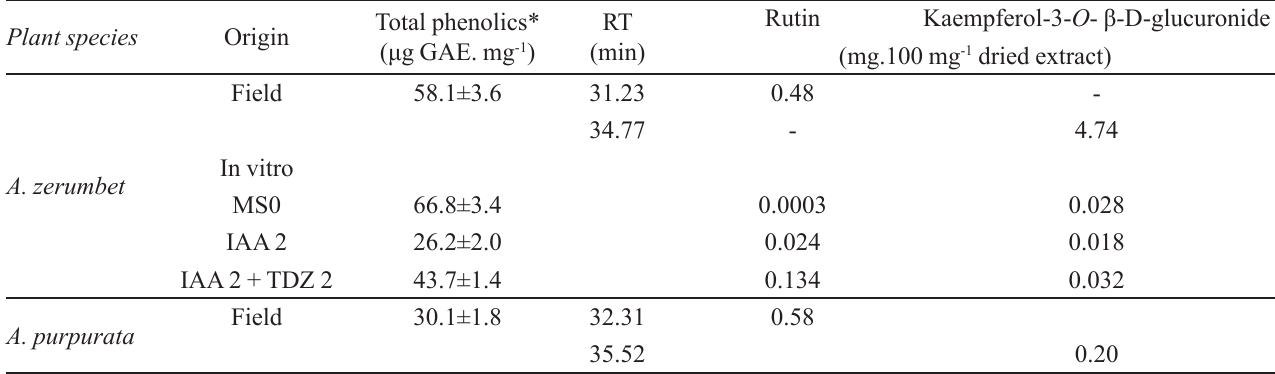
TABLE I - Flavonoids content in hydroalcoholic extracts of leaves of field-grown A. purpurata and Alpinia zerumbet cultured in vitro Plant